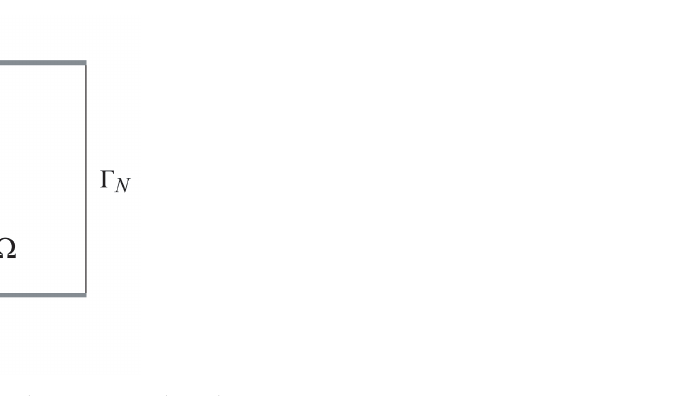
Figure 1. A two-dimensional region Ω and crack Σ